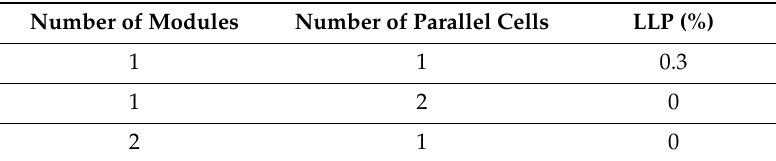
Table 5. LLP values for di ff erent configurations.